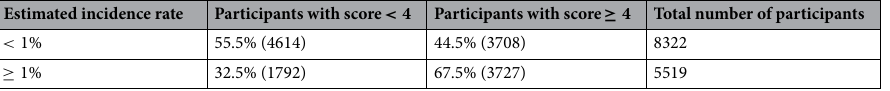
Table 4. Participant distribution over high and low predicted incidence areas.